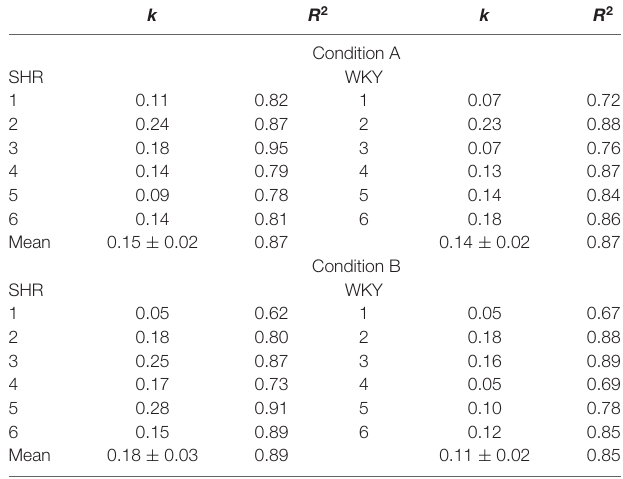
TABLE 1 | Individual and mean k and R 2 in both conditions.